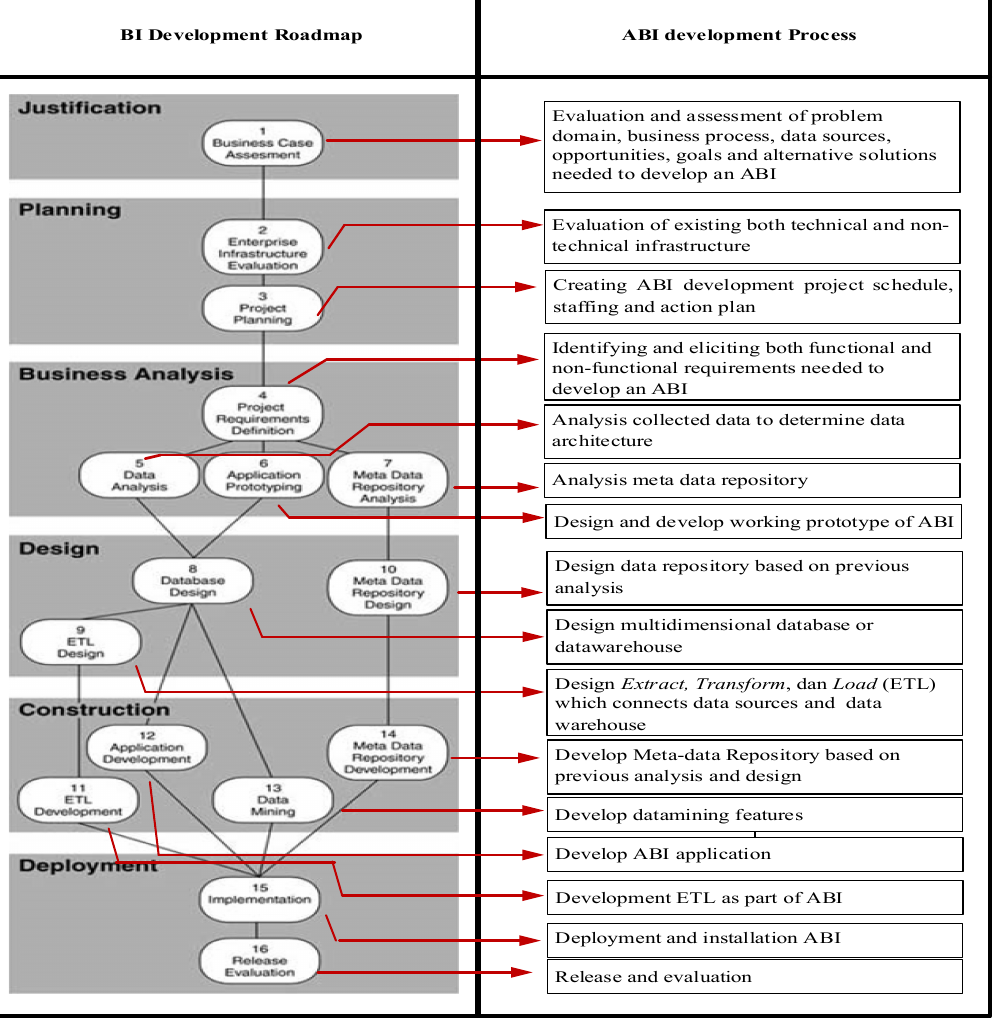
Fig. 1 ABI Development Framework